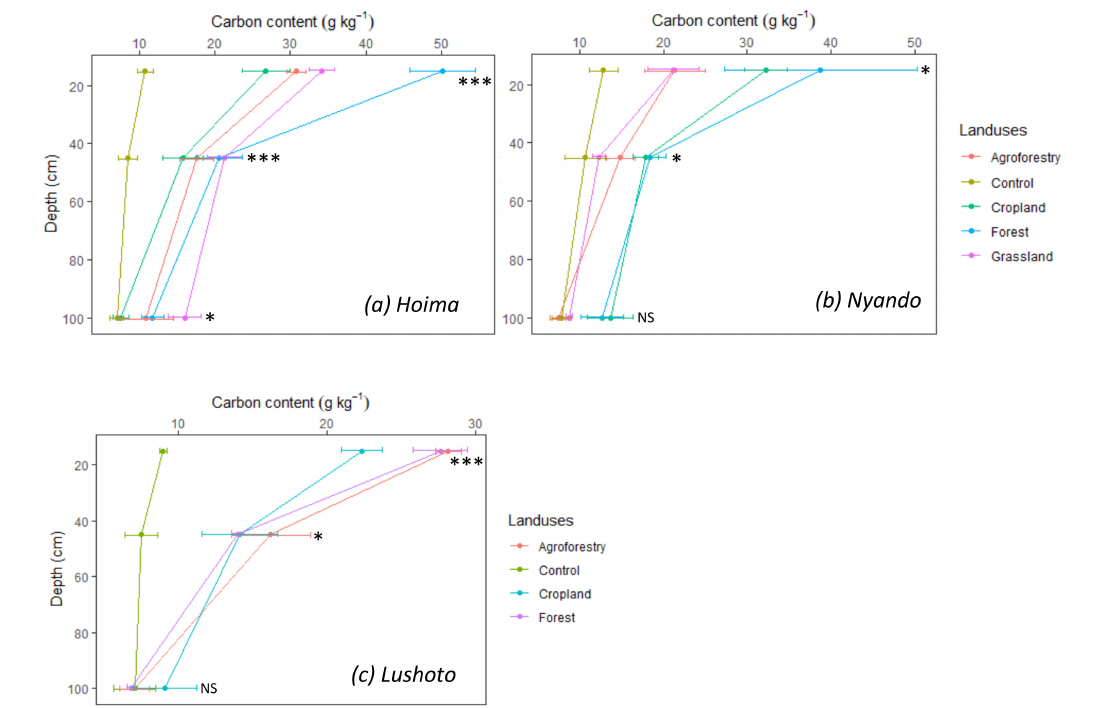
Figure 2. Soil organic carbon content in the deep soil profile (0–100 cm). Cropland, agroforestry, grassland, forest, and control land uses. Error bars show standard error of the mean. NS: non-significant, ***, **, and * indicate significant di ff erences at p ≤ 0.001, p ≤ 0.01, and p ≤ 0.05, respectively.